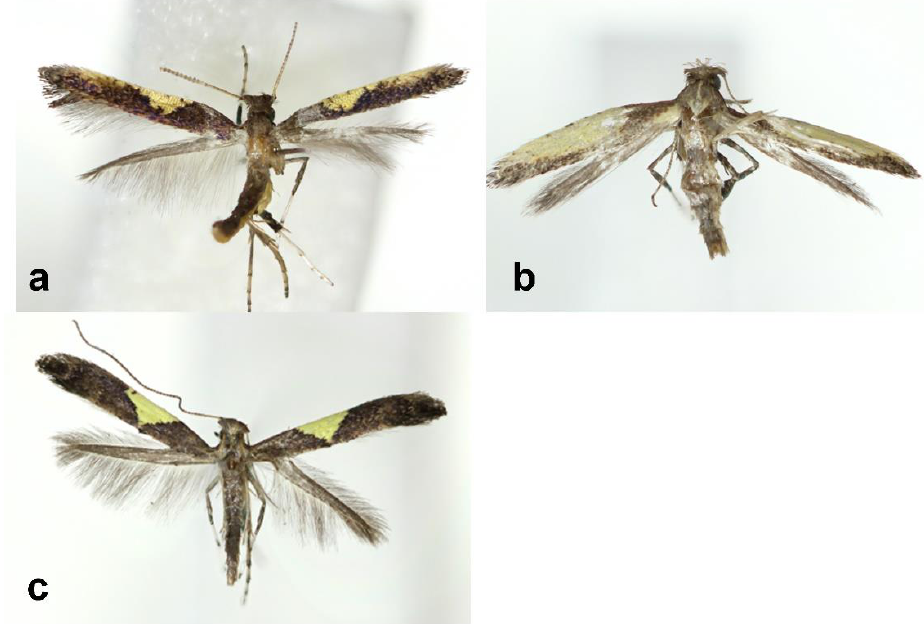
Figure 1. Adults of Caloptilia . ( a ). C. purpureus (Holotype, gen. slide no. HNUSEL-5592); ( b ). C. koreana (Holotype, gen. slide no. HNUSEL-5575); ( c ). C. xanthos (Holotype, gen. slide no. HNUSEL-